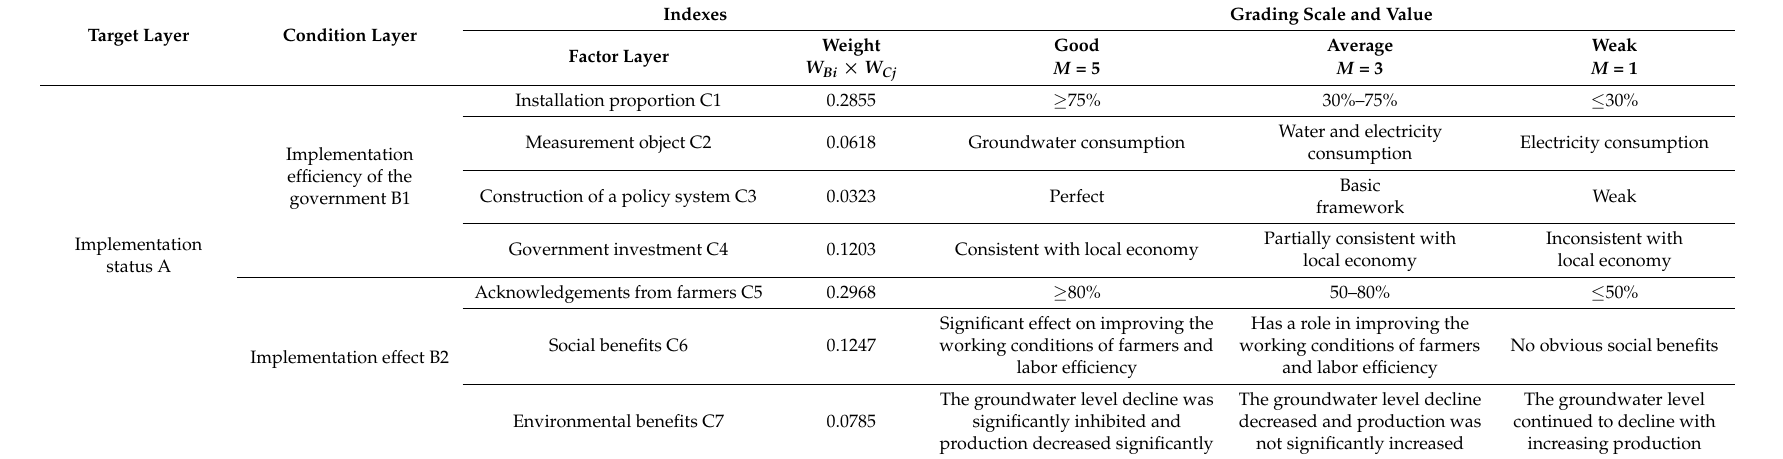
Table 2. Selected indexes for evaluating the implementation of PSMS.